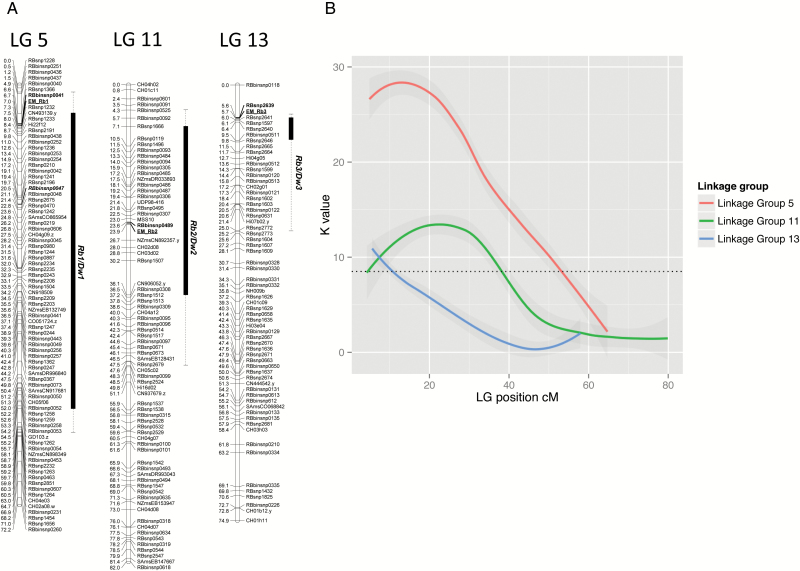
(A) QTLs by linkage group. Markers with a significance level of P<0.005 are highlighted in boxes, with P values between P>0.005 and P<0.05 shown as whiskers. (B) QTLs by position, including both SNP and STS marker data. K value of the QTL plotted by genetic distance in cM along linkage group 5 (red), linkage group 11 (green) and linkage group 13 (blue). The dotted line indicates the K value at the threshold for significance (P<0.05).